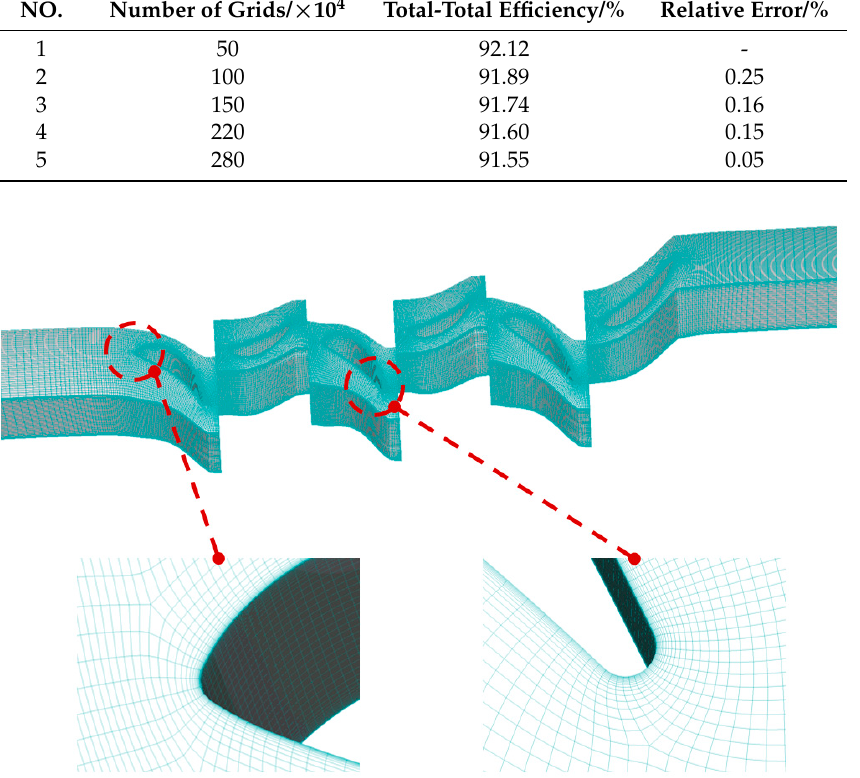
Figure 4. Grid schematic.